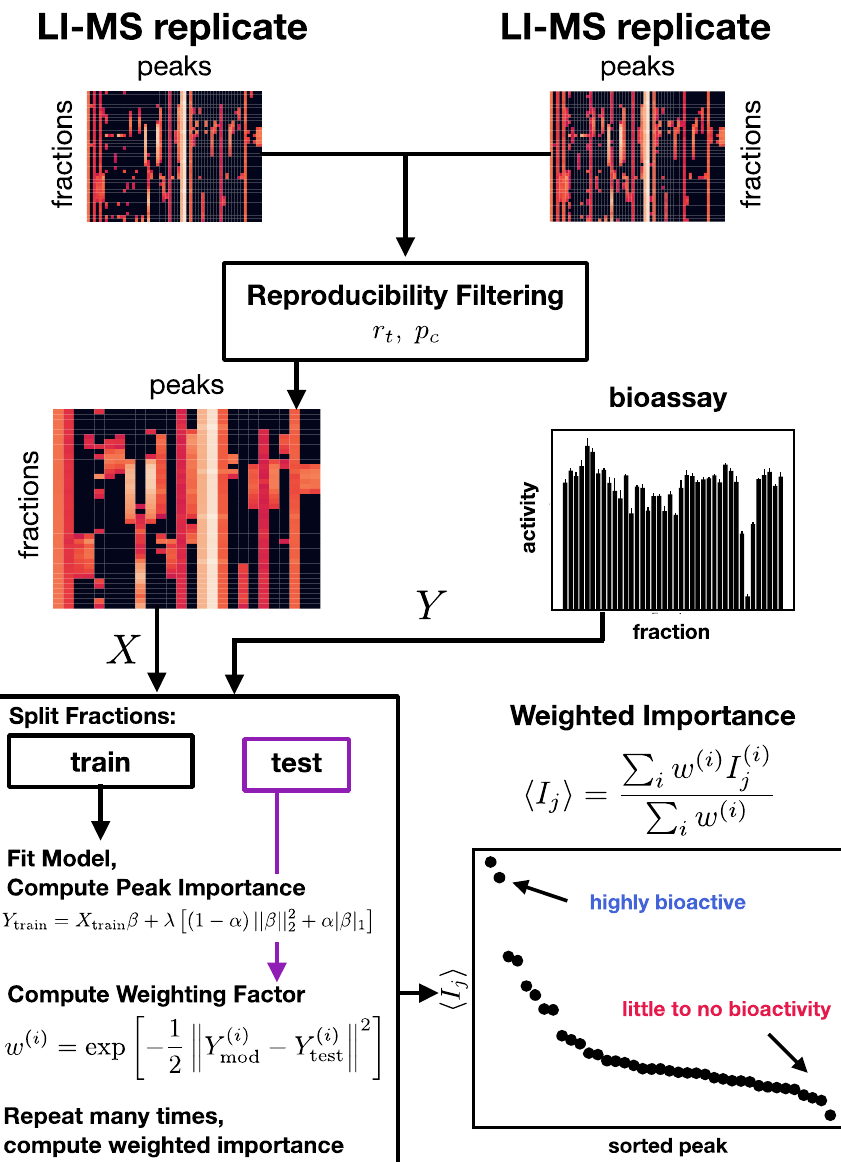
Figure 2. Computational pipeline developed for this study. Multiple LI–MS replicates are used to filter out nonreproducible MS peaks. The filtered MS data is then combined with the bioassay results and an ensemble of models created. Variable importance—the degree to which each individual MS peak contributes to the bioactivity—is computed from the model ensemble and used to identify bioactive compounds.